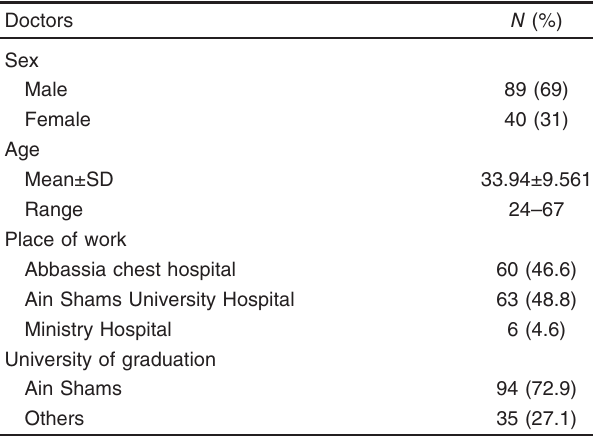
Table 5 Description of doctors according to number of chronic obstructive pulmonary disease patients seen per month in the